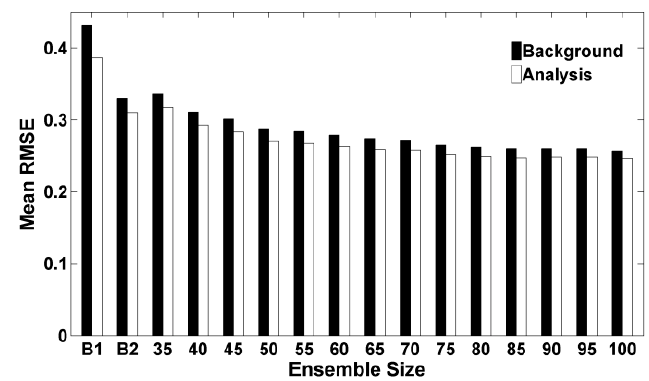
Figure 6. The mean RMSEs of DRP-4DVar with ensemble size of 35–100. Other assimilation parameters of the DRP-4DVar experiments are the same as those of the DRP-4DVar experiment in Exp-1. The mean RMSEs of the ETKF and the 4DEnVar methods in Exp-1 are used as benchmarks, which are noted as B1 and B2, respectively. The black bars and white bars denote the mean background RMSE and the mean analysis RMSE during the last 500 time steps, respectively.